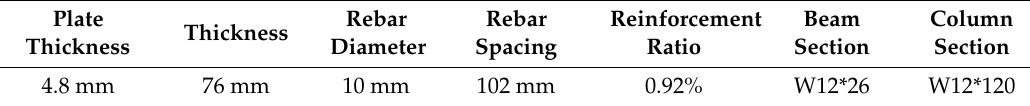
Table 1. Properties of cross sections refer to the AISC Manuals